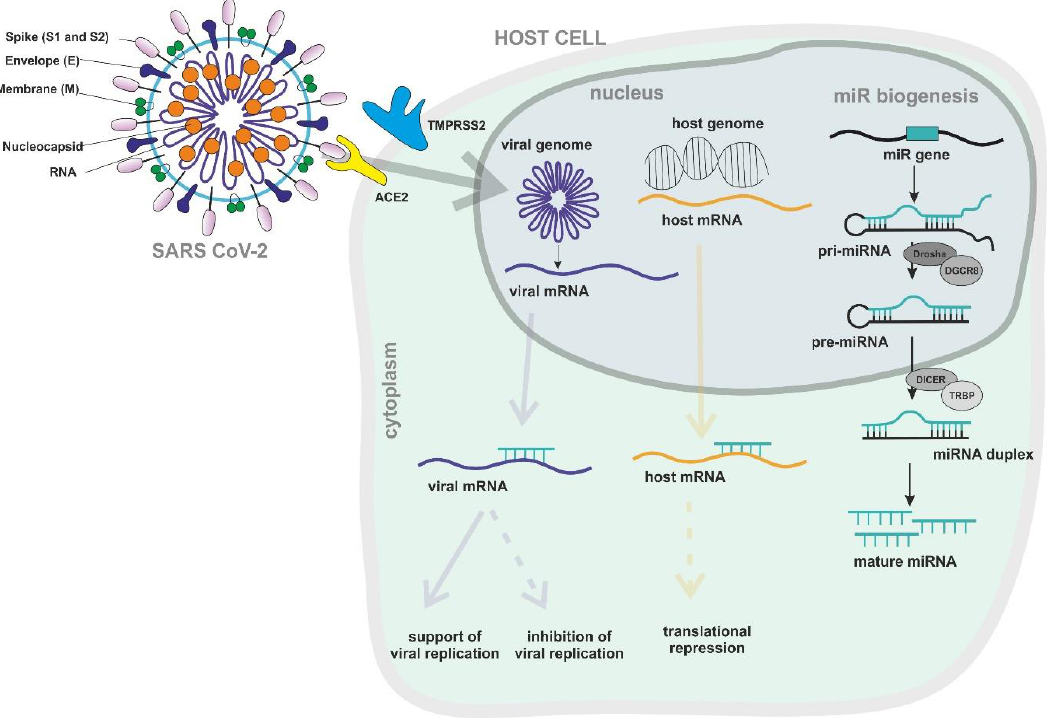
Figure 1. Schematic representation of severe acute respiratory syndrome coronavirus 2 (SARS-CoV-2) viral structure and the consequences of infection for the host cell concerning miRNA-mediated cellular regulation. mRNA: messenger RNA, pre-miRNA: precursor microRNA, pri-miRNA: primary microRNA.